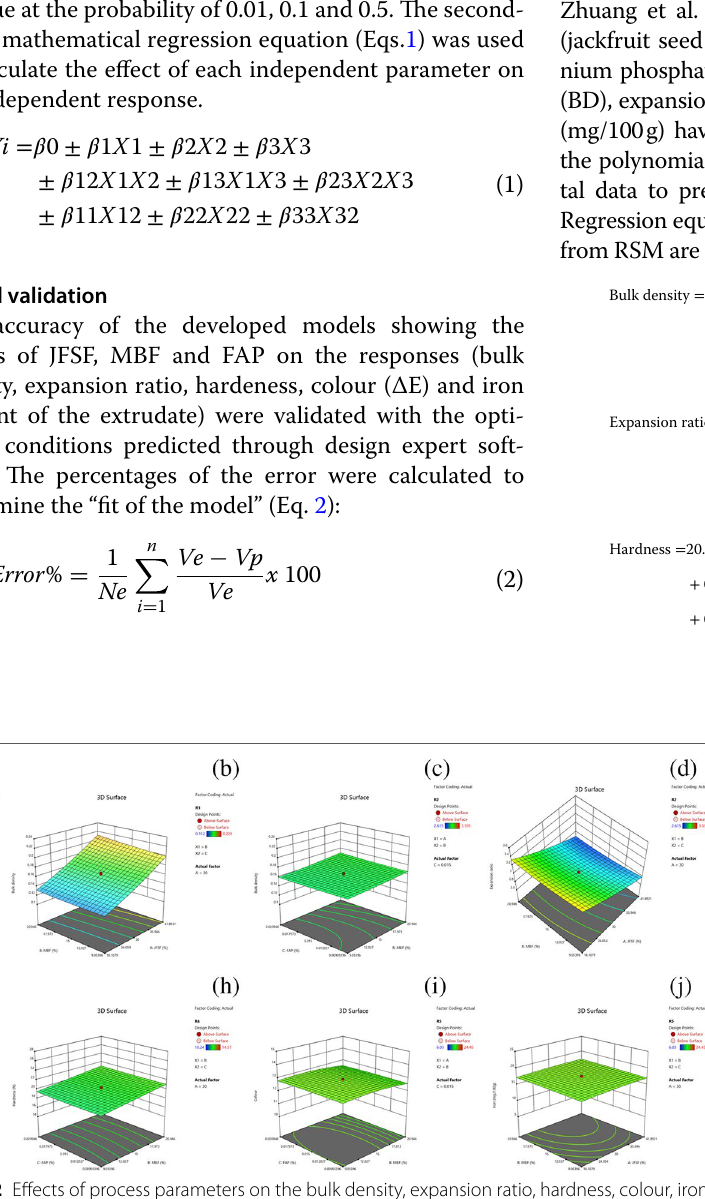
Fig. 2 Effects of process parameters on the bulk density, expansion ratio, hardness, colour, iron and overall acceptability of extruded snacks. a Effects of Jackfruit seed flour (JFSF) and Mung bean flour (MBF) on the bulk density of extruded snacks. b Effects of Ferrous ammonium phosphate (FAP) and Mung bean flour (MBF) on the bulk density of extruded snacks. c Effects of Jackfruit seed flour (JFSF) and Mung bean flour (MBF) on the expansion ratio of extruded snacks. d Effects of Ferrous ammonium phosphate (FAP) and Mung bean flour (MBF) on the expansion ratio of extruded snacks. e Effects of Jackfruit seed flour (JFSF) and Mung bean flour (MBF) on the hardness of extruded snacks. f Effects of Ferrous ammonium phosphate (FAP) and Mung bean flour (MBF) on the hardness of extruded snacks. g Effects of Jackfruit seed flour (JFSF) and Mung bean flour (MBF) on the colour (∆E) of extruded snacks. h Effects of Ferrous ammonium phosphate (FAP) and Mung bean flour (MBF) on the colour (∆E) of extruded snacks. i Effects of Jackfruit seed flour (JFSF) and Mung bean flour (MBF) on the iron content of extruded snacks. j Effects of Ferrous ammonium phosphate (FAP) and Mung bean flour (MBF) on the iron content of extruded